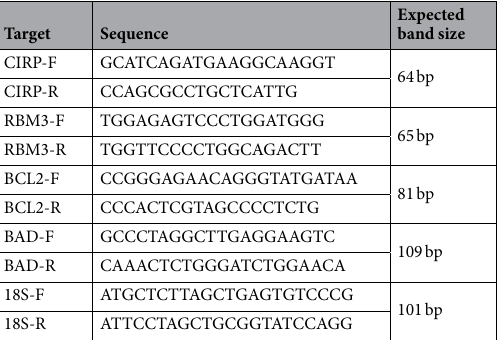
Table 1. Primers used for qRT-PCR. Annealing temperature for all primers was 60